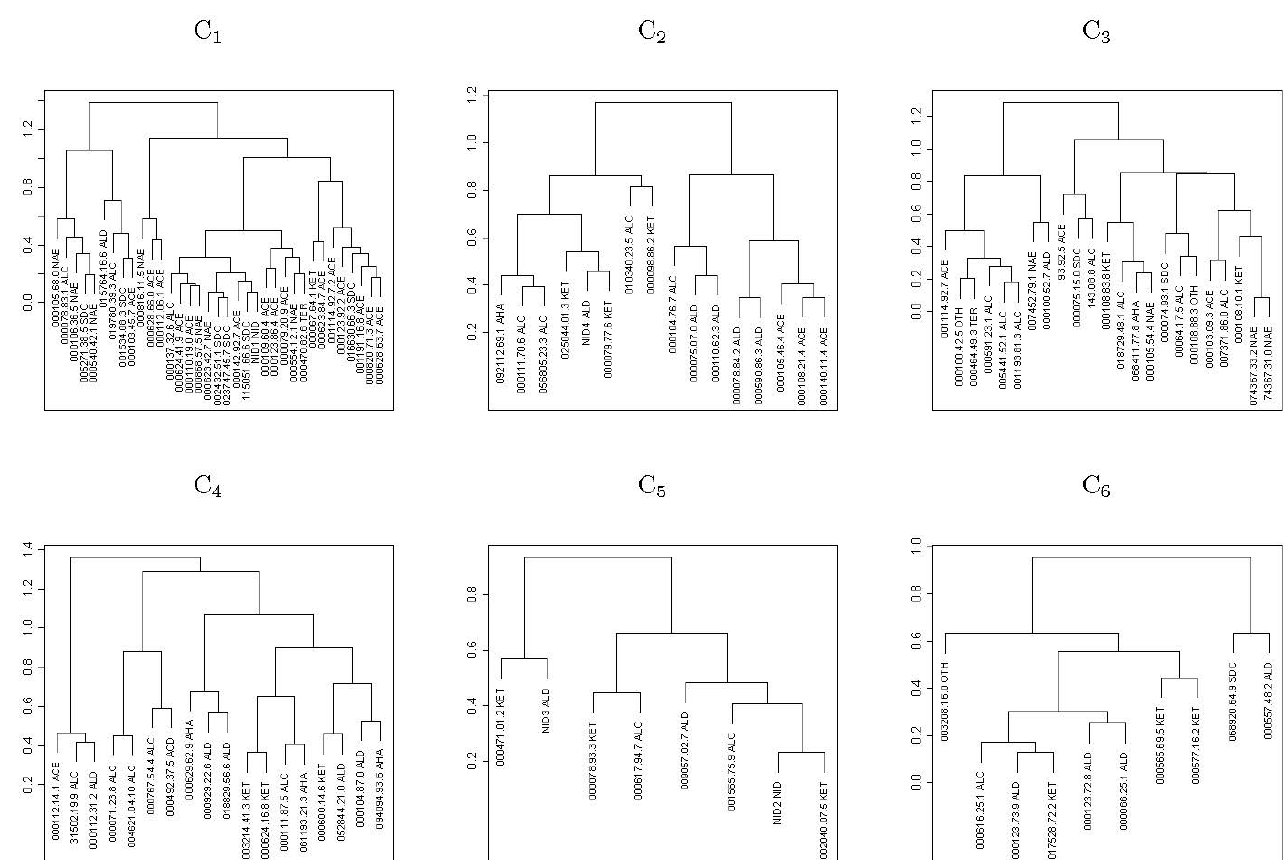
Figure 7. Detailed dendrograms of the six clusters ( C1 – C6 ) identified by hierarchical clustering ap- plied to individual volatile compounds analyzed for the near-isogenic lines (NILs) with introgression on melon chromosome 3 (SC3-5-7, SC3-5-8, SC3-5-12, SC3-5-13, and SC3-5-14) and the parental control ‘Piel de Sapo’ (PS). The individual volatiles are plotted by their respective CAS numbers (dots instead of dashes) plus their chemical compound classes. ACE, acetate esters; NAE, non-acetate esters; SDC, sulfur derived compounds; ALD, aldehydes; KET, ketones; ALC, alcohols; TER, terpenes; AHA, aliphatic compounds; OTH, other compounds; NID, unidentified compound.